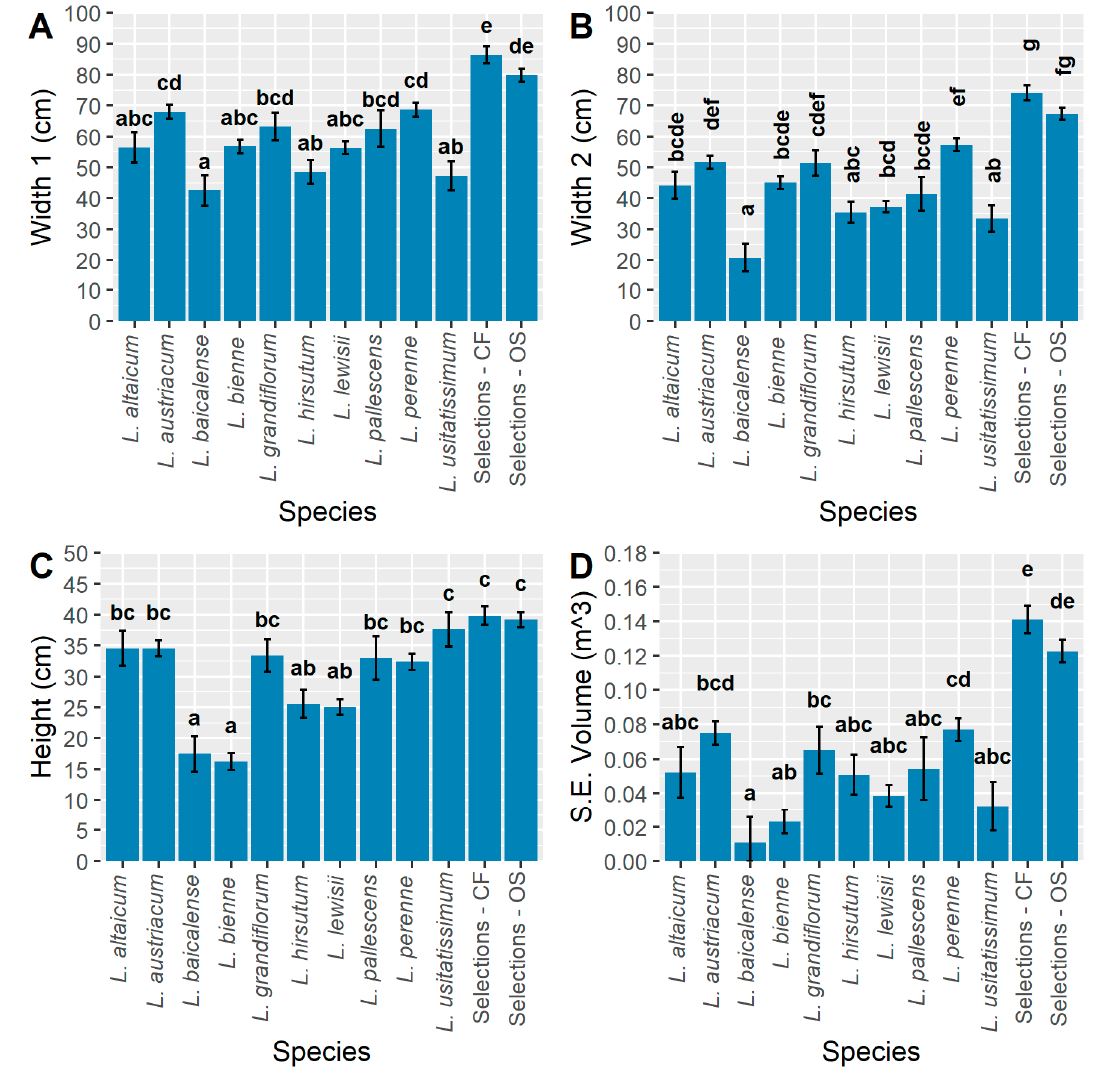
Figure 7. Comparison of wild flax species with CF and OS selections for mean ± S.E. year one plant size trait values: ( A ) width 1 (cm), ( B ) width 2 (cm), ( C ) height (cm), and ( D ) semi-ellipsoid (S.E.) volume (m 3 ). Means separations (5% HSD) are displayed as letters above the columns denoting sig- nificance.